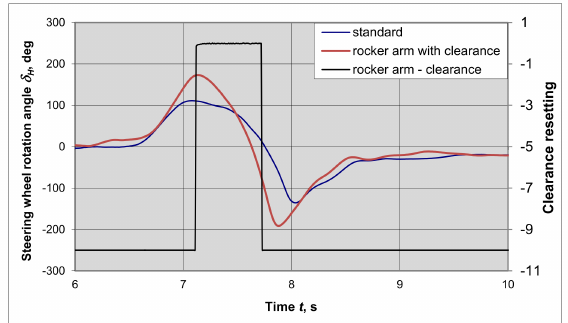
Figure 11. The angle of rotation of the steering wheel during the lane change maneuver (driving at ~40 km/h).